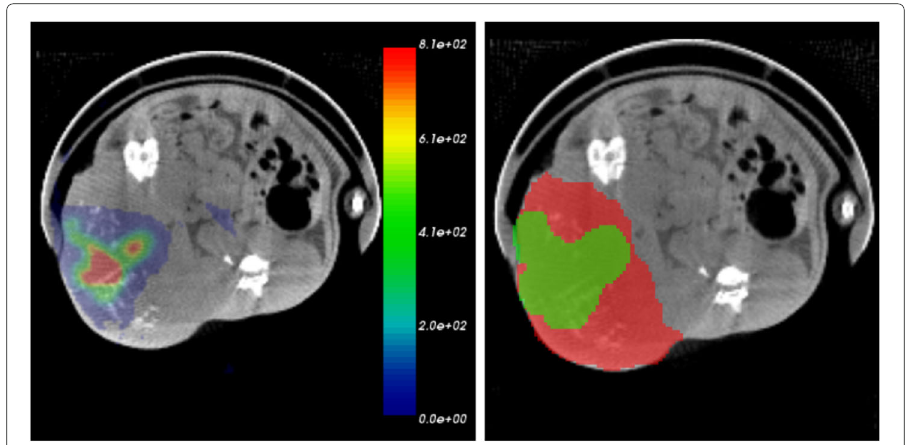
Fig. 2 Possible choice of VOI selections. Illustration of in vivo SPECT/CT tumor image with 111 In activity (left) and possible choice of VOI selections (right): total volume of tumor (red) and VOI from SPECT image containing only radioactivity perfusion region